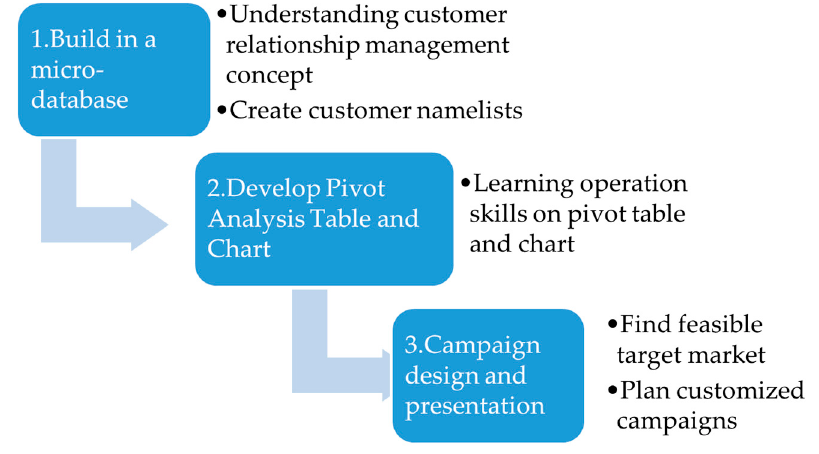
Figure 2. The three learning steps of project-based learning course. Source: This research.